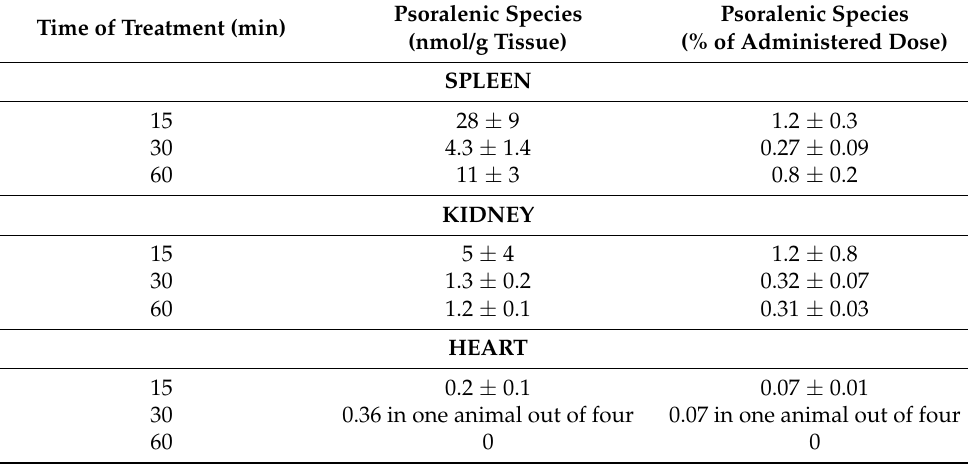
Table 4. Quantification of all the species with a psoralenic UV absorption spectrum extracted from the spleen, kidneys or heart, and detected at 312 nm (assuming the same molar extinction coefficient for all species). No correction for recovery yield was applied. Data in the table are expressed as mean ± SEM ( n = 5, 4, and 6 for 15, 30 and 60 min, respectively). Psoralenic Species Psoralenic Species Time of Treatment (min) (nmol/g Tissue) (% of Administered Dose) SPLEEN 28 ± 9 1.2 ±